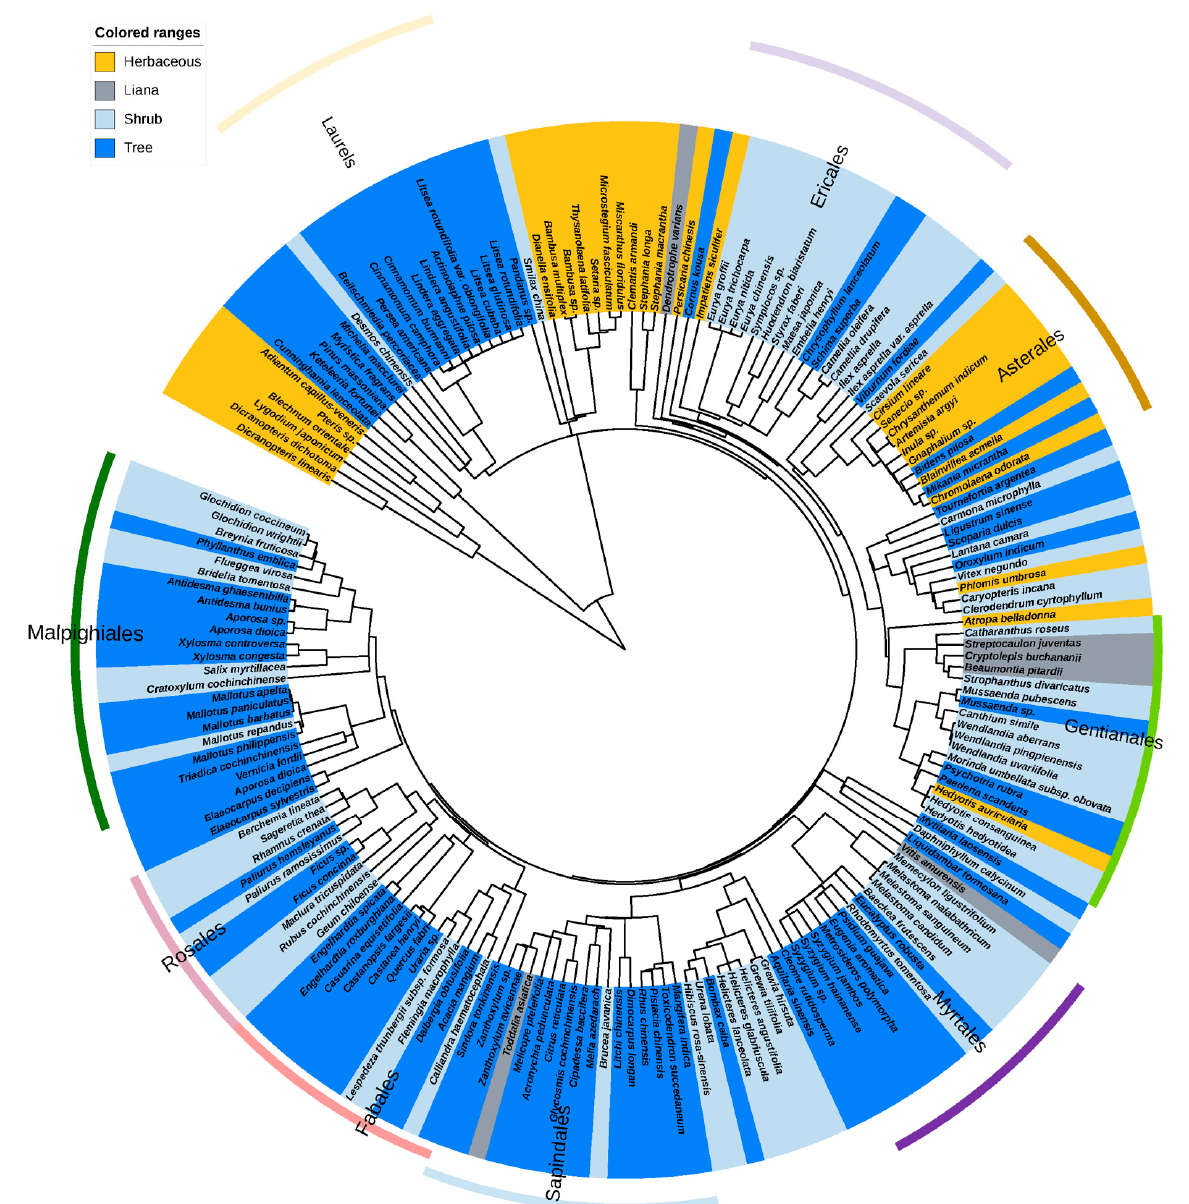
Figure 5. The host plants’ phylogenetic tree for Cassytha filiformis in China. Yellow notes herbs. Grey notes lianas. Light blue notes shrubs; and darker blue notes trees. Hosts belonging to ferns, gymnosperms, and angiosperms are coded with different colors corresponding to Table S1.